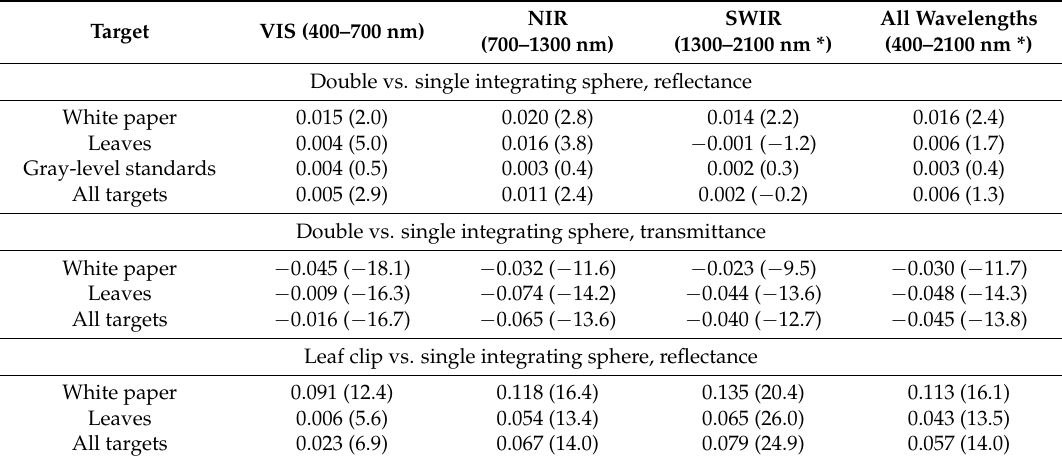
Table 4. Mean absolute difference (mean relative difference in parenthesis) of spectra measured with different methods at visible (VIS), near-infrared (NIR), shortwave-infrared (SWIR), and all